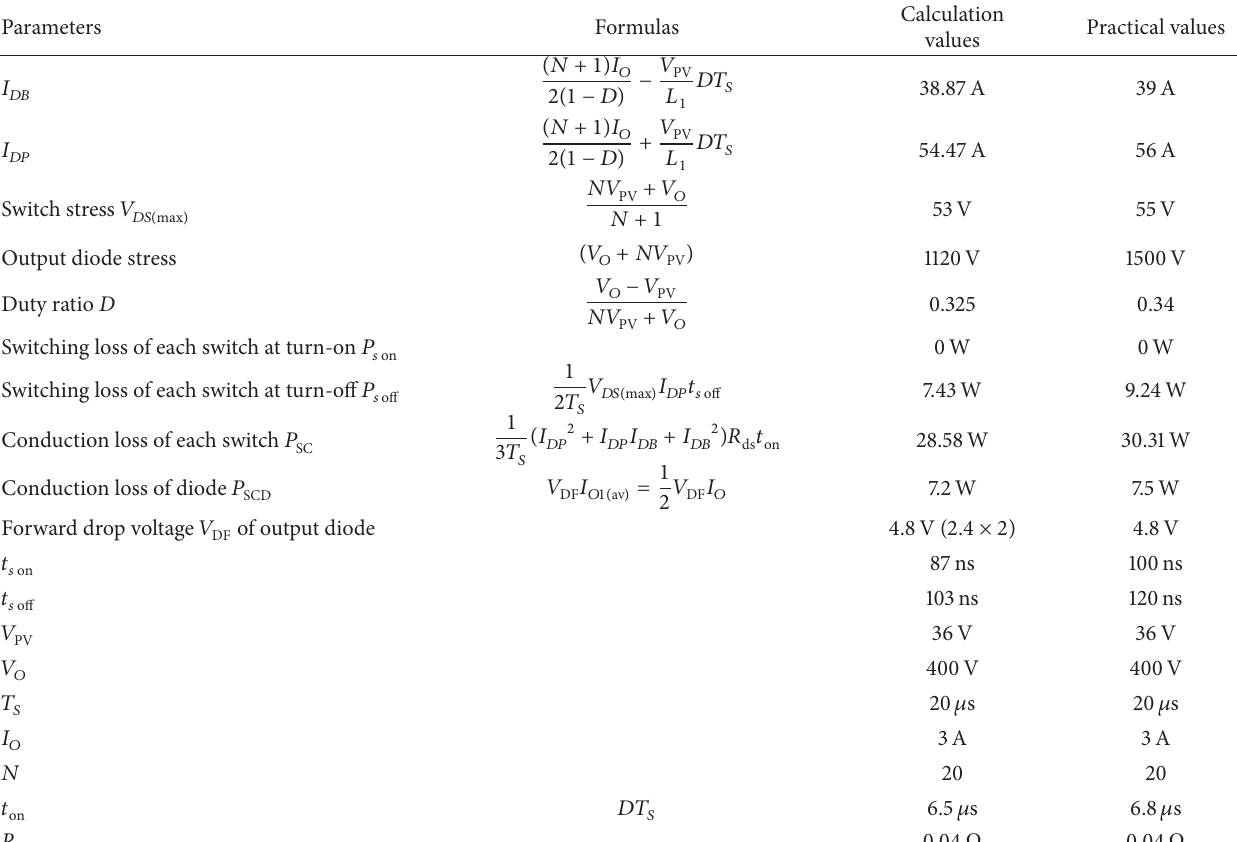
Table 4: Parameter values of the boost converter with boost type snubber under full-load condition.